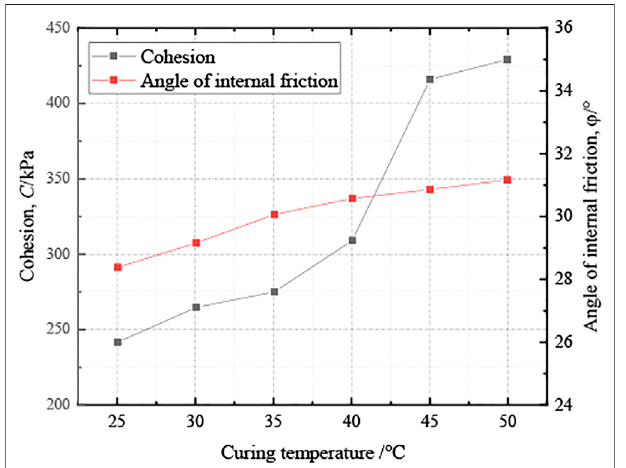
FIGURE 6 | Relationship curve between shear strength indexes and curing